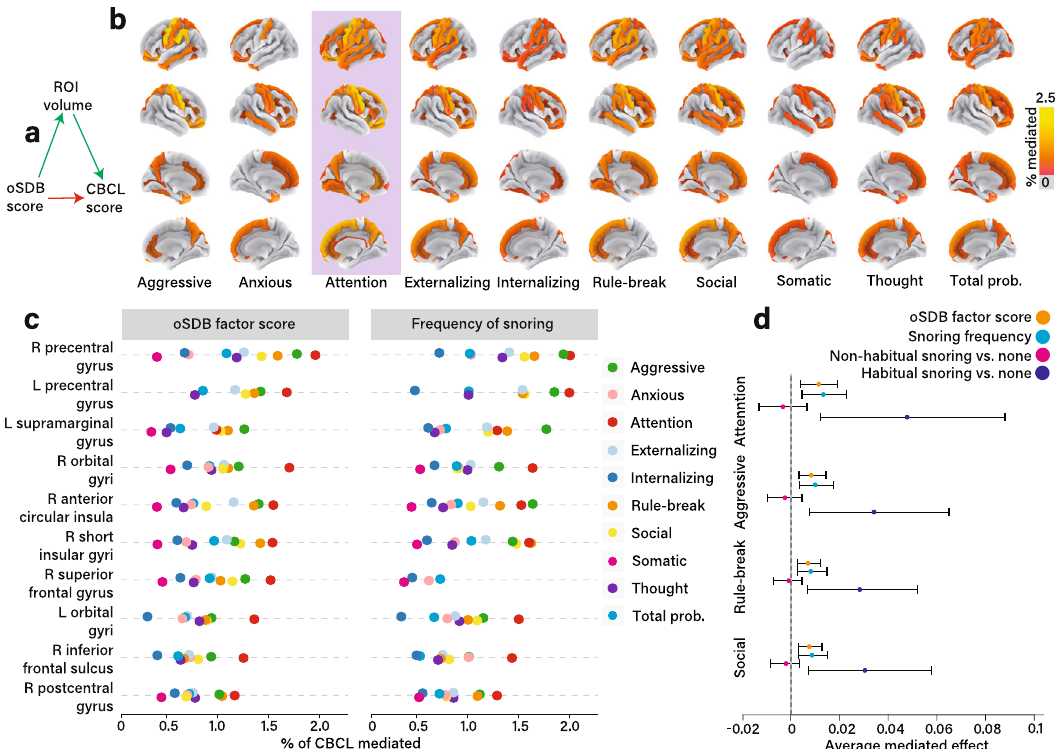
Fig. 4 Frontal lobe regions mediate the relationship between obstructive sleep disordered breathing (oSDB) and Child Behavioral Checklist (CBCL) scores. a General outline of the mediation model that estimates the extent of the covariate-adjusted relationship between oSDB factor score and the CBCL measures apportioned to alterations in cortical volume. These mediation effects expressed as a proportion of the total effect (% mediated) were projected on to atlas-based cortical effect size maps for CBCL scores ( b ). All mediation models included age, sex, race/ethnicity, history of asthma, and the total household income before taxes as fi xed effects, and the recruitment site and the scanner serial number as random effects. The most widespread and strongest mediation effects were identi fi ed for attention problems (highlighted). c The top ten mediated effects for cortical regions of interest (ROI) for both oSDB factor score and the frequency of snoring showing similar effects. d Explores the clinical threshold for the frequency of snoring as a predictor for CBCL scores. Following recategorization of snoring frequency as none, non-habitual (less than three nights a week) and habitual (at least three nights a week), mediation effects were identi fi ed only for habitual snoring. All mediation effects were derived from jointly modeling two regressions — the fi rst assessed the ROI using the predictor and the second assessed the CBCL score using the ROI as a predictor. The error bars span 95% con fi dence intervals associated with the average mediated effect and were obtained by bootstrapping 1000 replicates. A threshold of P < 0.05 following correction for false discovery was applied to all mediation models in addition to removing mediation effects whose con fi dence intervals crossed zero. Mediation effects for abnormal CBCL scores as a categorical variable are shown in Fig. S3. Source data are provided as a Source Data fi